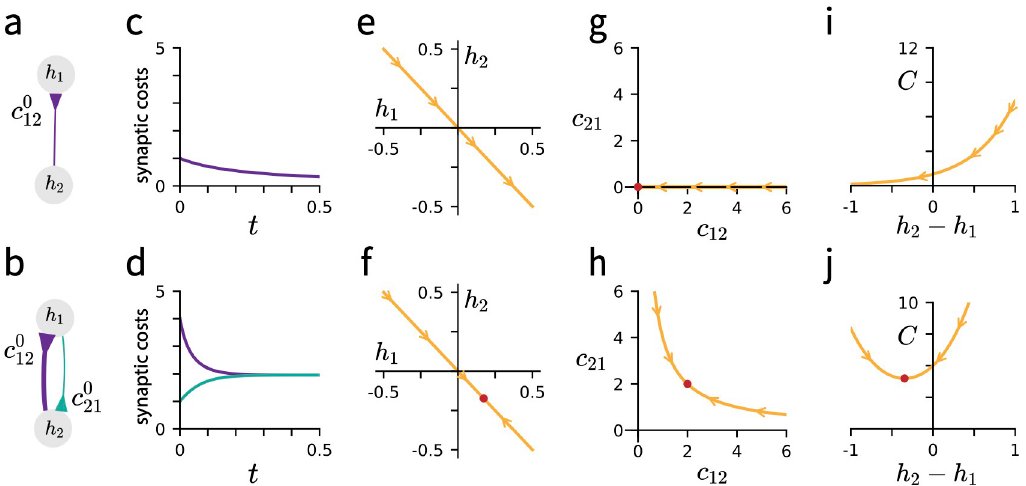
Fig 3. Network topology determines the geometry of the task-preserving manifold and the dynamics of synaptic balancing. Top row: ReLu network with two hidden units connected by a single synapse, corresponding to initial synaptic cost c 0 row: ReLu network network with two hidden units connected reciprocally, with initial synaptic costs c 0 diagrams showing topology and initial synaptic costs, indicated by line thickness. Input and output neurons are not shown. (c-d) Trajectory of synaptic costs over the course of synaptic balancing. Line colors match synapse colors in panels (a-b). Panel (c) matches (31) and panel (d) matches (29). (e-f) The feasible set of h satisfying (22), with flow lines indicating trajectory of synaptic balancing. Panel (f): Red point indicates the (finite) minimizer of the total cost. (g-h) Tradeoff between c 12 and c 21 as a function of h 2 − h 1 , with red point indicating the optimal value of total cost C = c 12 + c 21 . (i-j) Total cost C as a function of h 2 − h 1 . (i) Optimal cost is zero, attained at an infinite value of h . (j) Optimal cost is positive, attained at finite h .